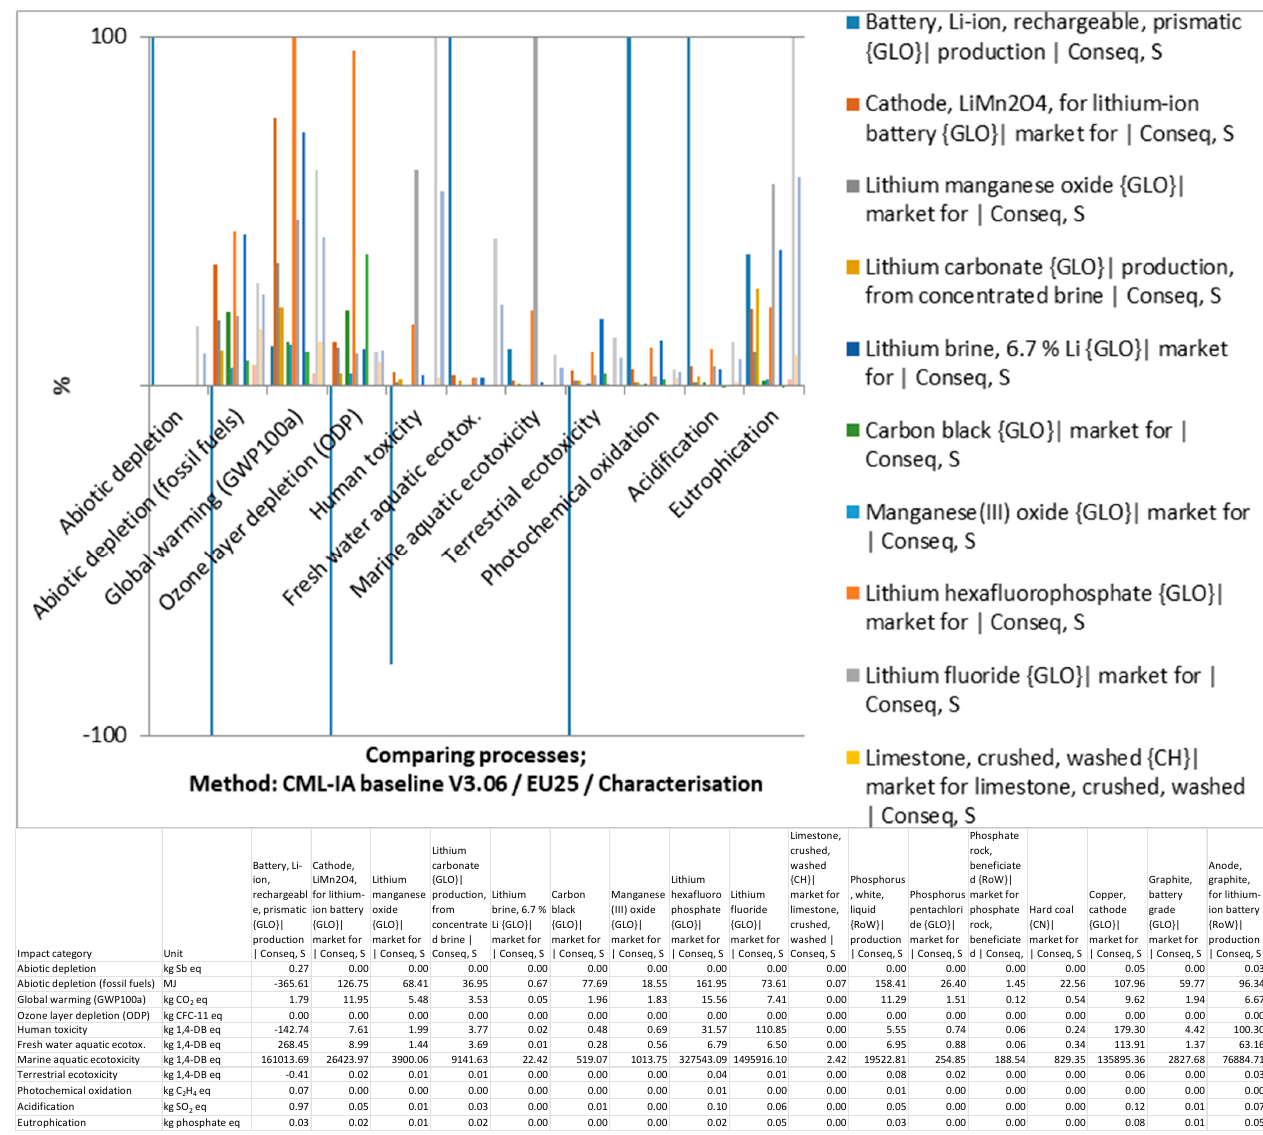
Impact category